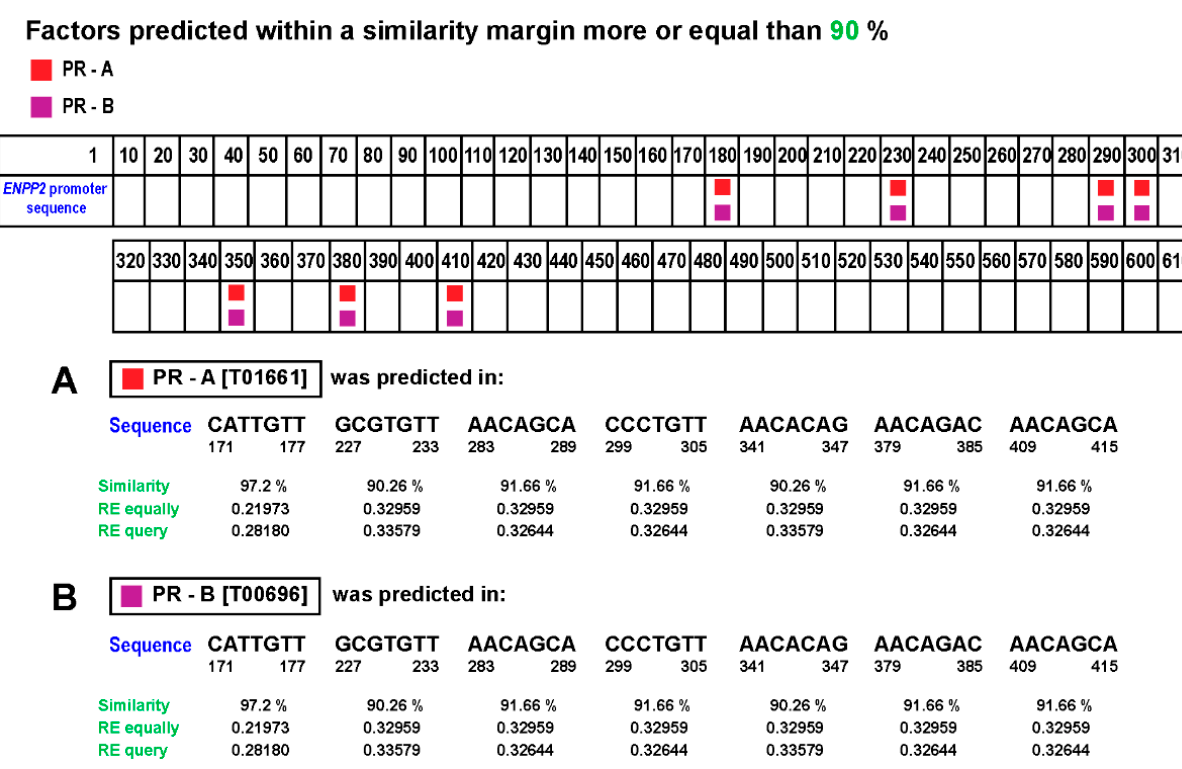
Figure 9. Possible binding sites for PR receptor in the ENPP2 promoter sequence. Seven potential sequences were found for ( A ) PR isoform A and ( B ) PR isoform B in the ENPP2 promoter.